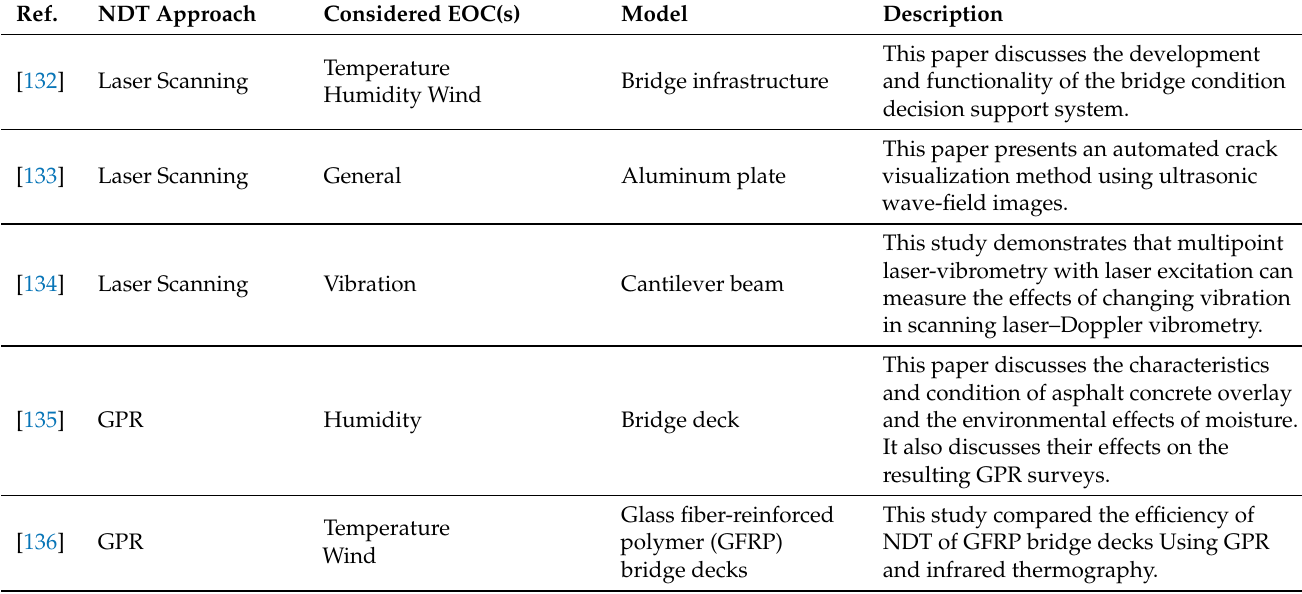
Table 3. Examples of studies considering the effects of EOCs on NDE using laser scanning and GPR